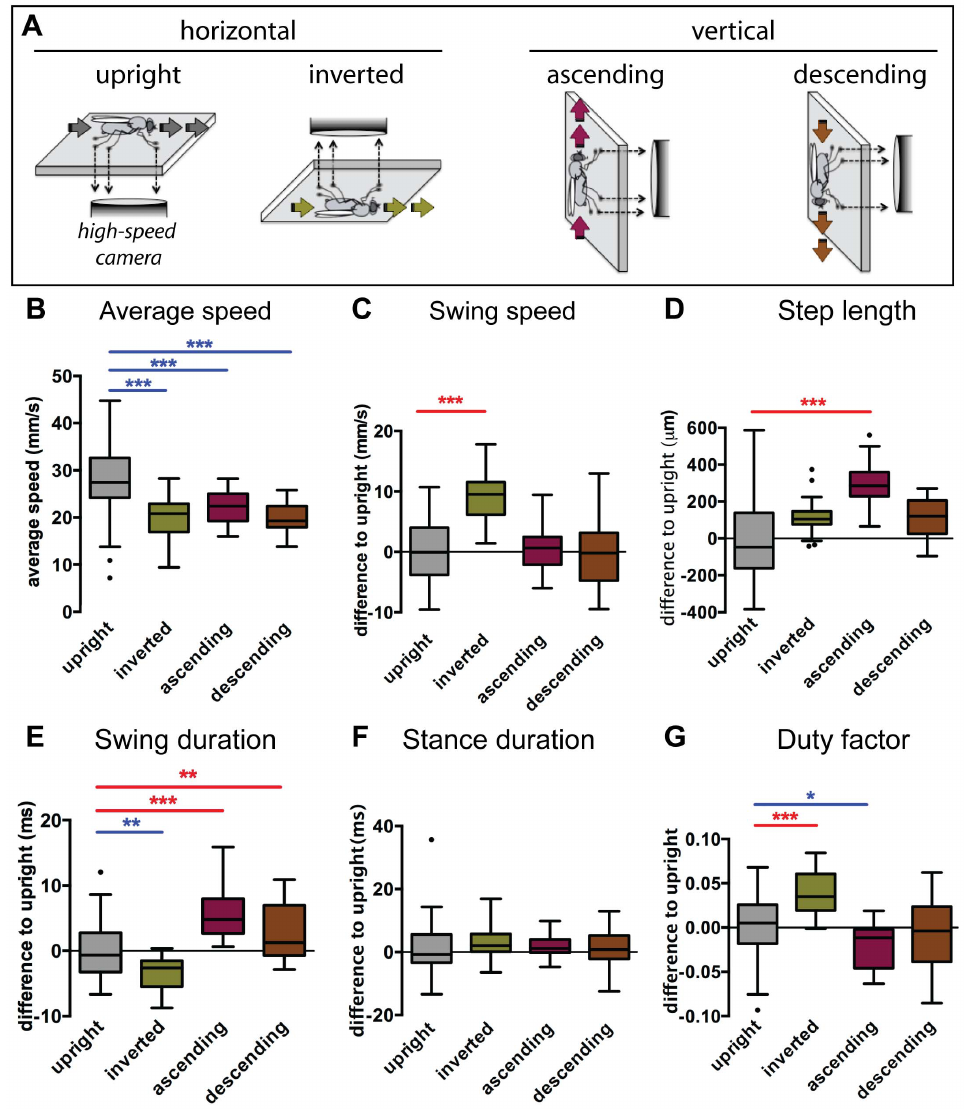
Figure 1. Imaging setup and step parameters. (A). Schematic of the recording setup. The fTIR apparatus was oriented in order to allow the flies to walk freely inside a walking chamber either horizontally (upright or inverted) or vertically (ascending or descending). A high-speed camera recorded body and tarsal contacts on the optical glass, see [39] for details. Fly schematic adapted from [73]. (B–G) Boxplots represent the median as the middle line, with the lower and upper edges of the boxes representing the 25% and 75% quartiles, respectively; the whiskers represent the range of the full data set, excluding outliers. Circles indicate outliers. Grey represents upright controls (n=71, from [39]), green for inverted (n=28), purple for ascending (n=28) and brown for descending (n=23). For C–G data was residual normalized and expressed as the difference to the upright control. Statistical analysis with one-way ANOVA followed by Tukey’s post hoc test (for normal distributions in panels B, C and E) or Dunn’s post hoc test (for non-normal distribution in panels D, F and G), * P , 0.05; ** P , 0.01; *** P , 0.001. Statistically significant increases or decreases are indicated in red and blue, respectively. (B) Non-upright animals display significantly reduced walking speed. (C) Swing speed was significantly increased in inverted walking animals. (D) All non-upright animals display increased step length. (E) Swing duration is increased only in ascending and descending animals while inverted animals show a small decrease. (F) Stance duration remains unchanged for all conditions. (G) Duty factor strongly increases in inverted walking animals while it is minimally reduced in ascending